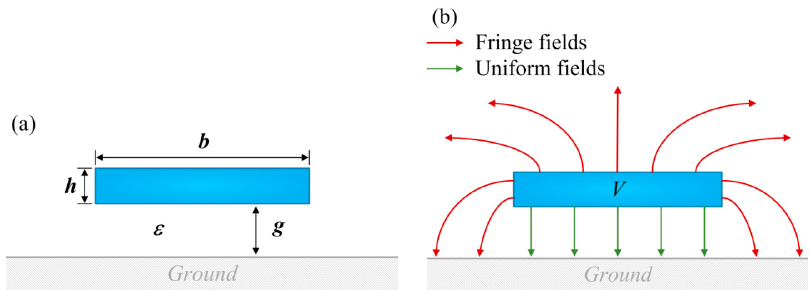
Figure 1. ( a ) The cross-sectional view of a flat-plate capacitor; ( b ) The field lines resulted by a bias voltage V , where b , g , h and ε are width, gap, thickness and permittivity of dielectric, respectively. Figure 2. Schematic diagram of the fringe fields of the etching-hole.